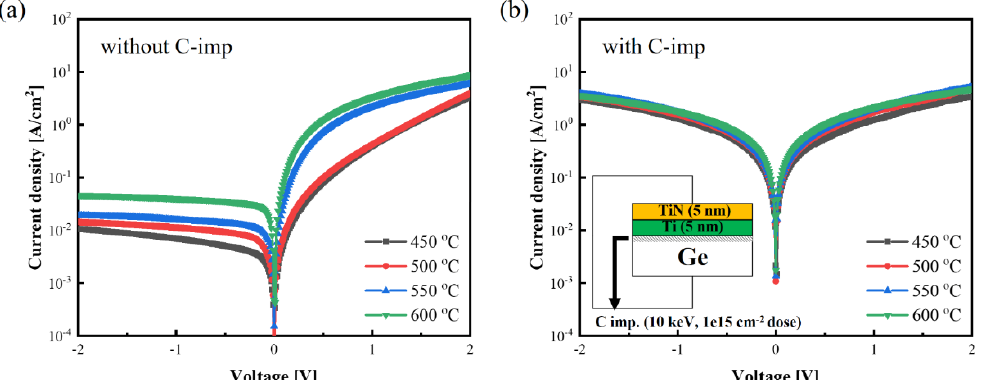
Figure 1. J - V characteristics of the Ti/Ge contact ( a ) without and ( b ) with C-imp at RTA temperatures in a range of 450–600 °C for 60 s in N 2